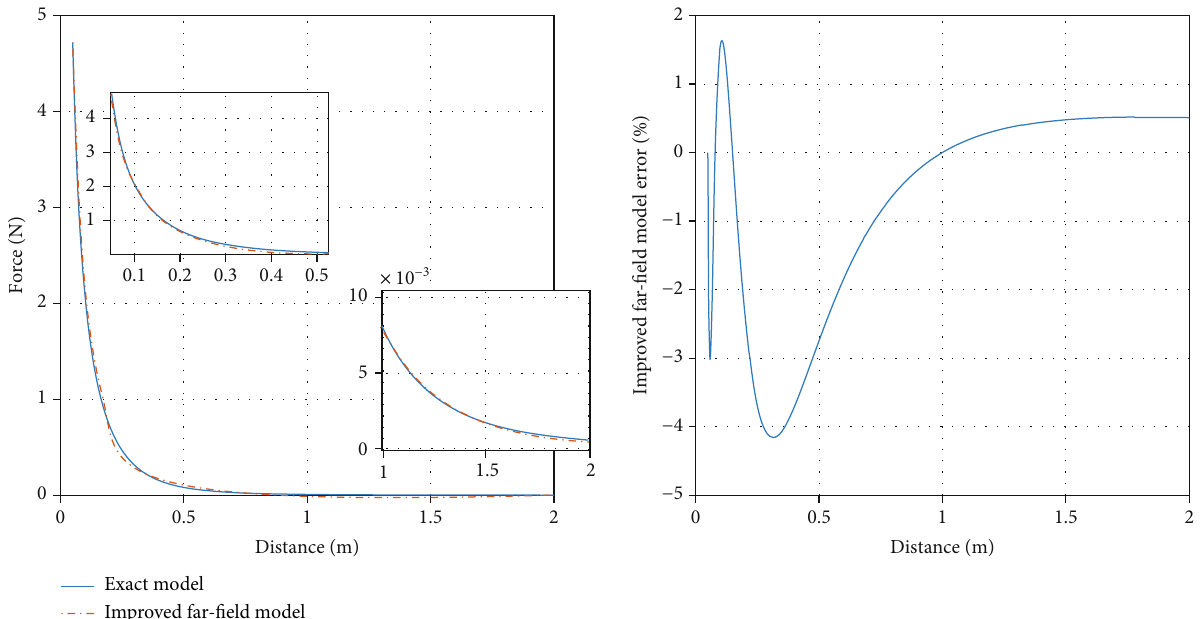
Figure 5: Calculation results and percent error of the improved far- fi eld model.